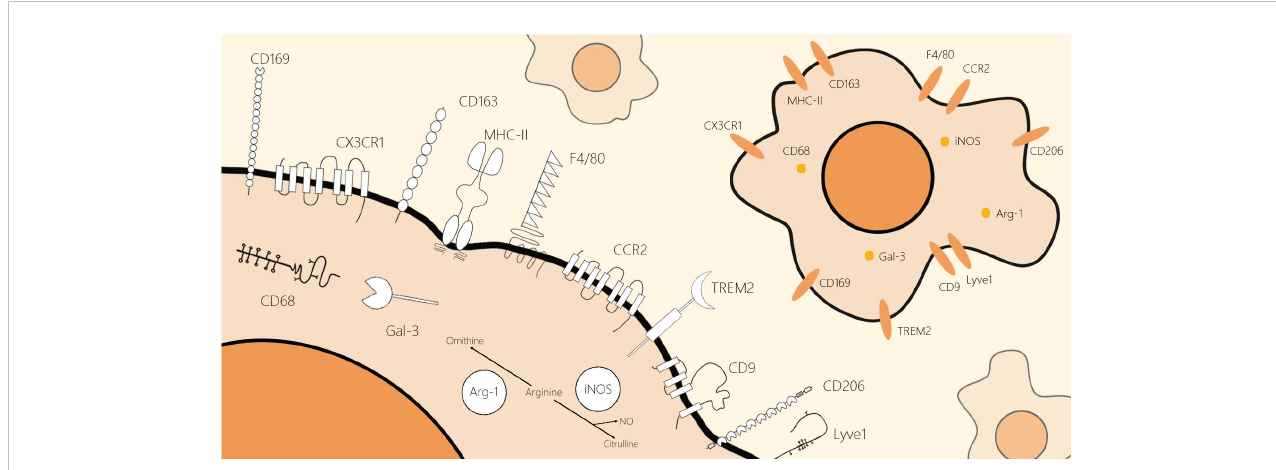
FIGURE 1 Schematic molecular structure and location of classical and novel markers of the macrophages. These markers of macrophages can be roughly divided into two categories by their location: cell surface markers and intracellular markers. F4/80, CCR2, CD169, CX3CR1, CD206, CD163, Lyve1, CD9, TREM2, and MHCII are macrophage markers located on the cell membrane. Moreover, CD68, iNOS, Arg-1, and Gal-3 are macrophage markers located inside the cell. All schematics of markers are based on their two-dimensional molecular